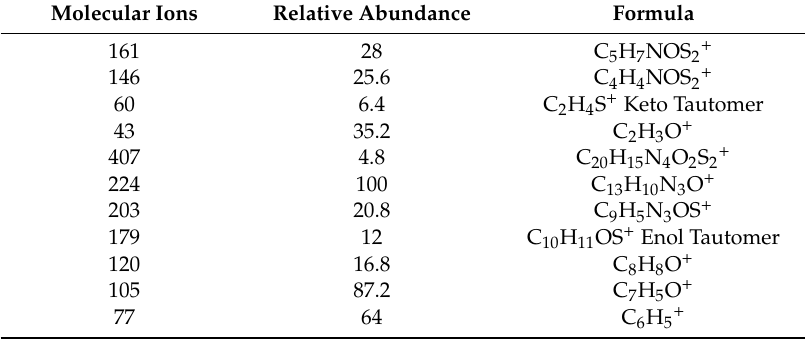
Table 4. The selected molecular ions with their formula and their relative abundance of Compound 3